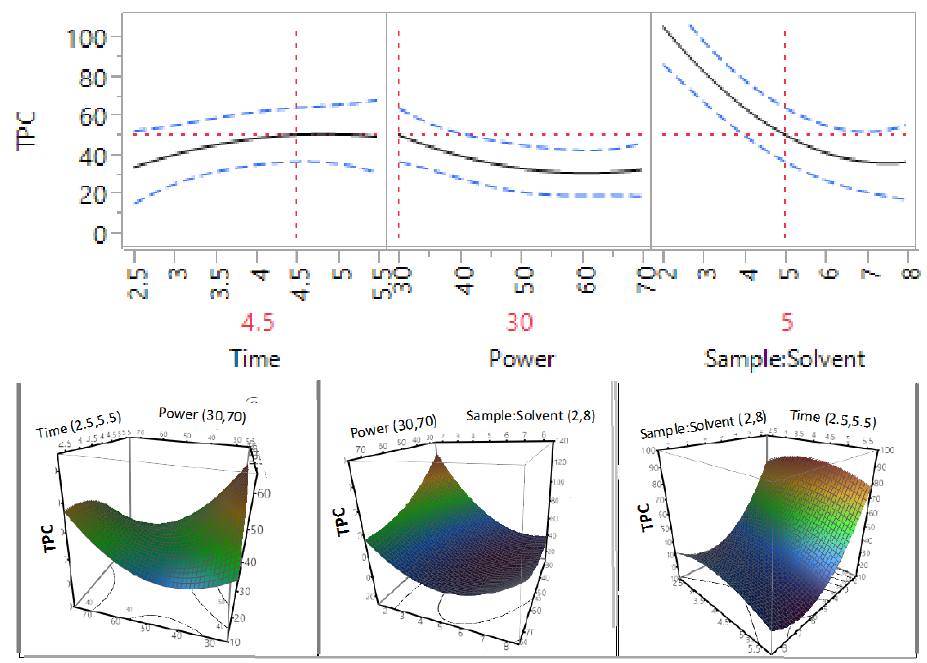
Figure 4. Impact of time (2.5–5.5 min), power (30%–70%, 360–840 W) and sample-to-solvent ratio (2–8 g/100 mL) on TPC (mg GAE/g).